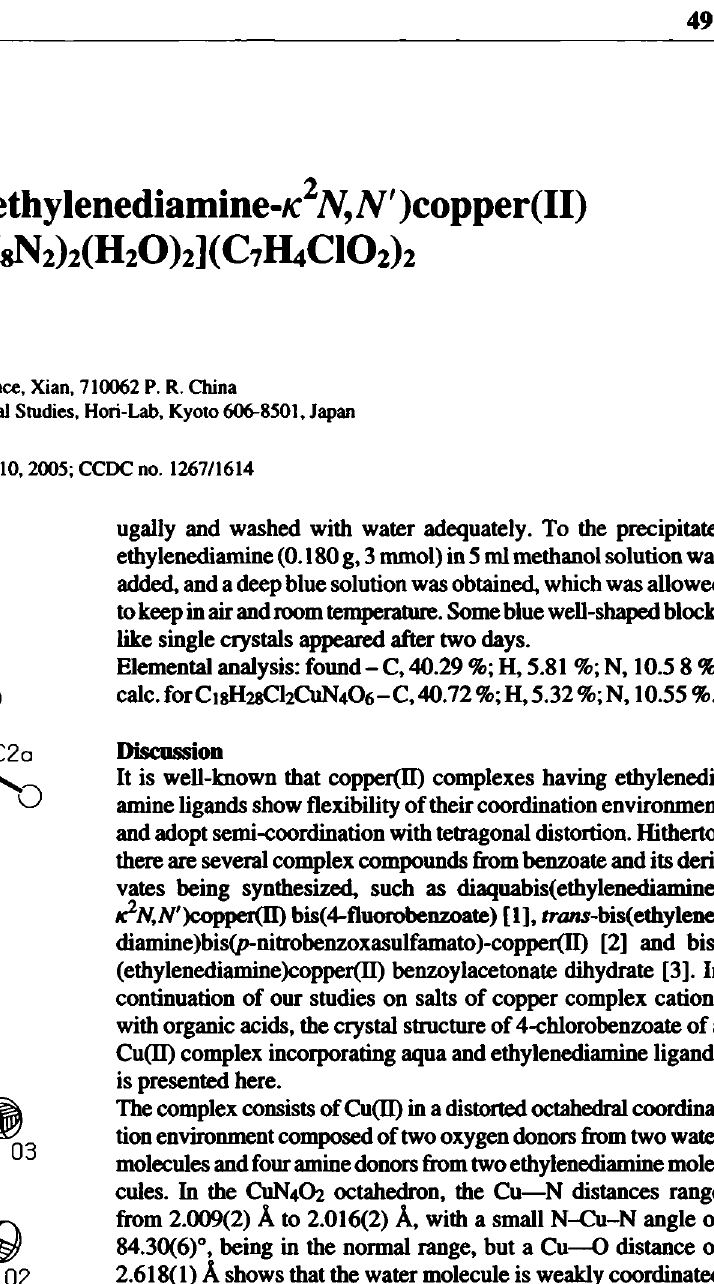
Table 1. Data collection and